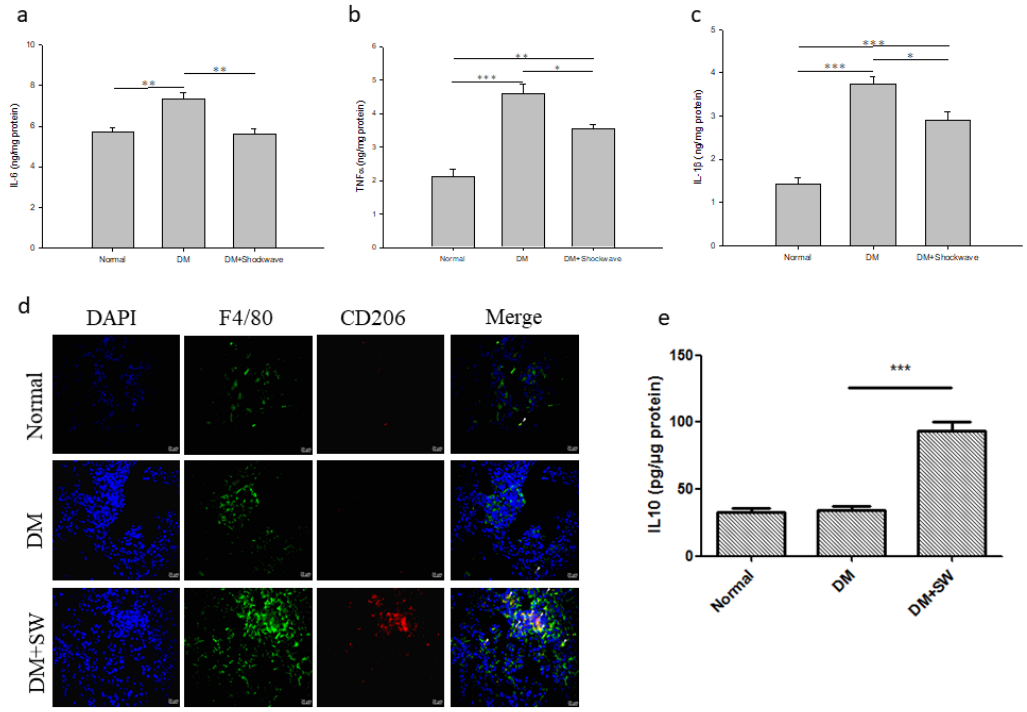
Figure 6. Low-energy SW prevented diabetes-induced pancreatic tissue inflammation. ( a,b,c ) Pancreatic tissue expression of inflammatory mediators IL-6, TNFα and IL-1 β ; ( d ) Representative images of pancreatic tissue IF stained with DAPI (blue), F4/80 (green) and CD206 (red) indicating anti-inflammatory M2 macrophages; ( e ) Pancreatic tissue expression of anti-inflammatory mediator IL-10. Scale bar = 20 μm. * p <0.05, ** p <0.01, *** p <0.001 ( n = 6–10).